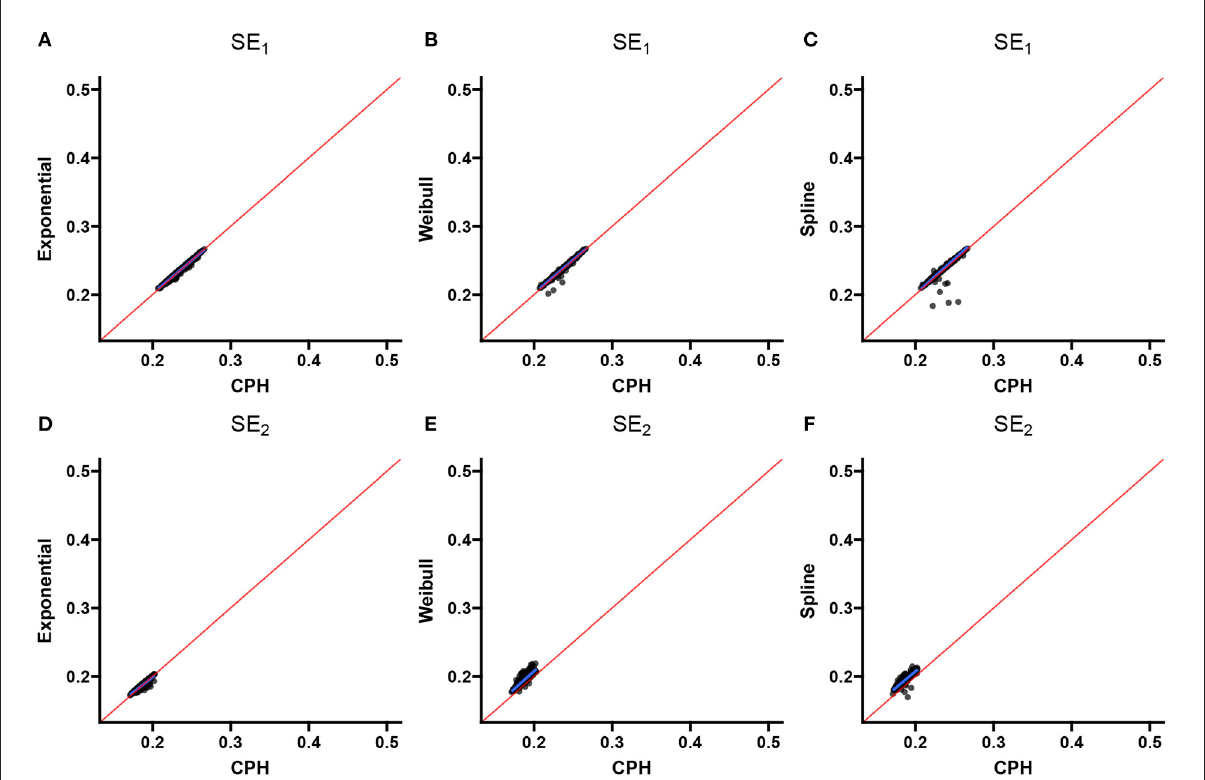
FIGURE5 Scenario 1: Correlation with CPH standard errors. Scatterplots show the correlation between standard error estimates from the exponential (A,D) , Weibull (B,E) , and spline models (C,F) for the event of interest (A–C) and the competing/clearance event (D–F) with standard error estimates from the CPH model using exact time data. The blue line is the simple regression line and the red line is the identity